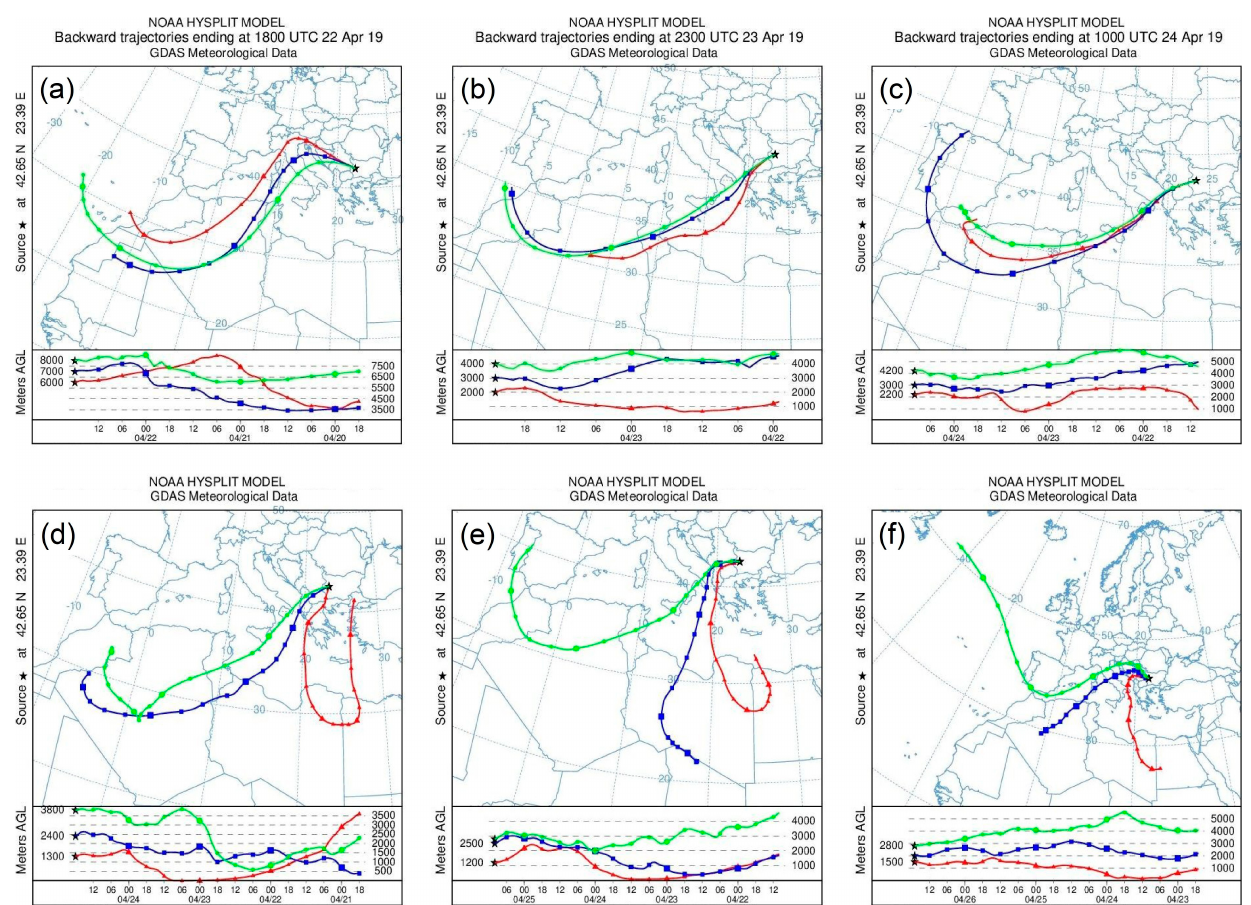
Figure 8. HYSPLIT backward trajectories ending above Sofia at heights of the observed aerosol/dust layers, during or close to the lidar measurements conducted on ( a ) 22 April 2019, ( b ) 23 April 2019, ( c , d ) 24 April 2019, ( e ) 25 April 2019, and ( f ) 26 April 2019. The red, blue, and green colored trajectories refer to selected end-point heights (in ascending order) denoted next to the black star symbols in the bottom sections of panels ( a – f ).